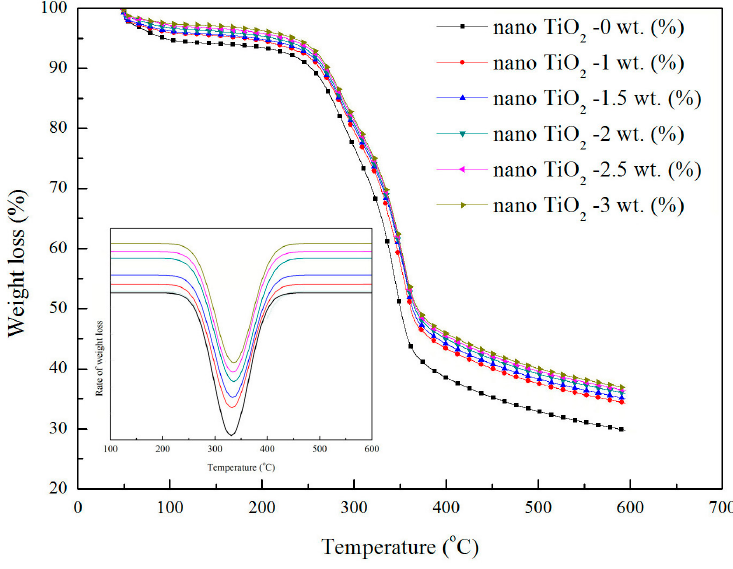
Figure 7. TGA curves of wheat straw fiber with different surface-modified TiO 2 nanoparticle contents.